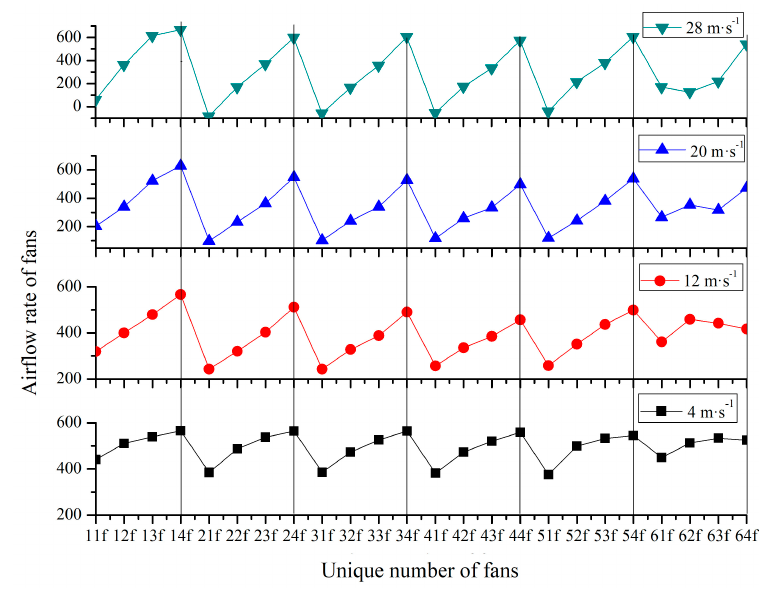
Figure 9. Airflow rate under crosswind conditions.